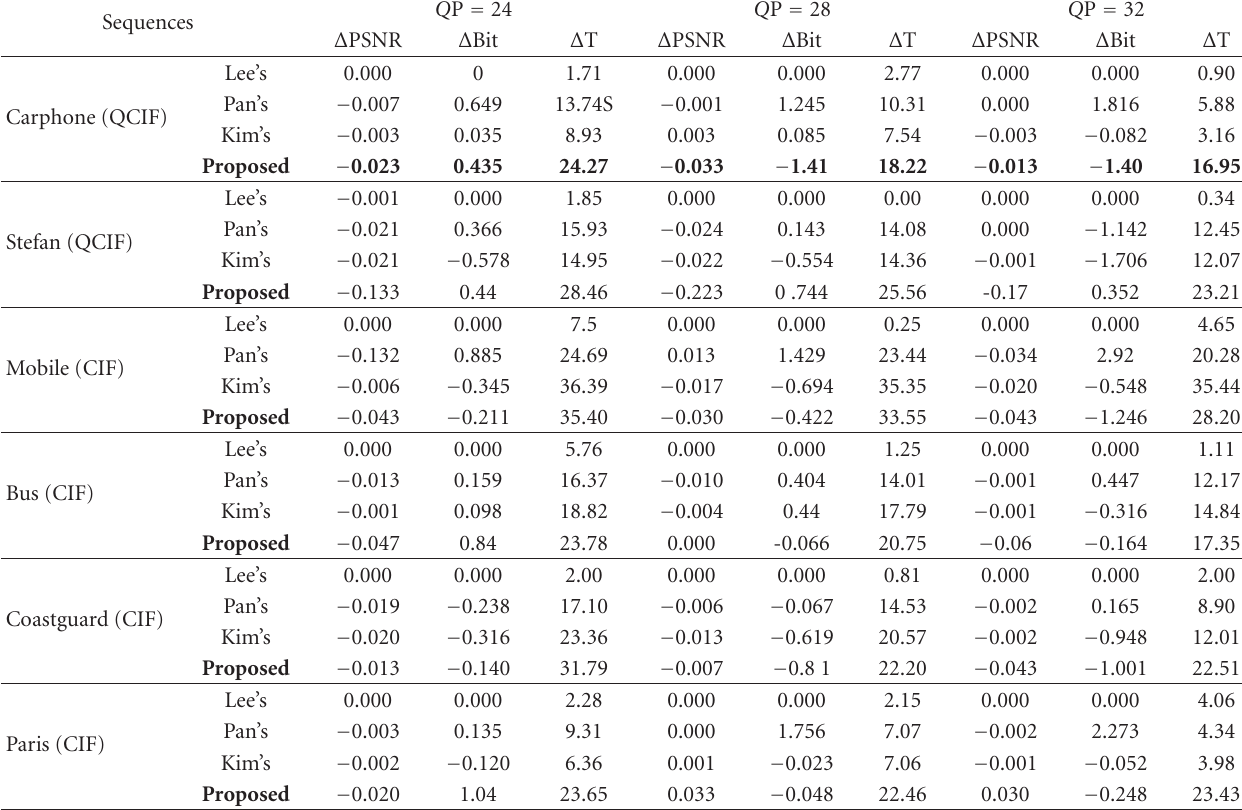
Table 3: Comparison between the proposed and some well-known